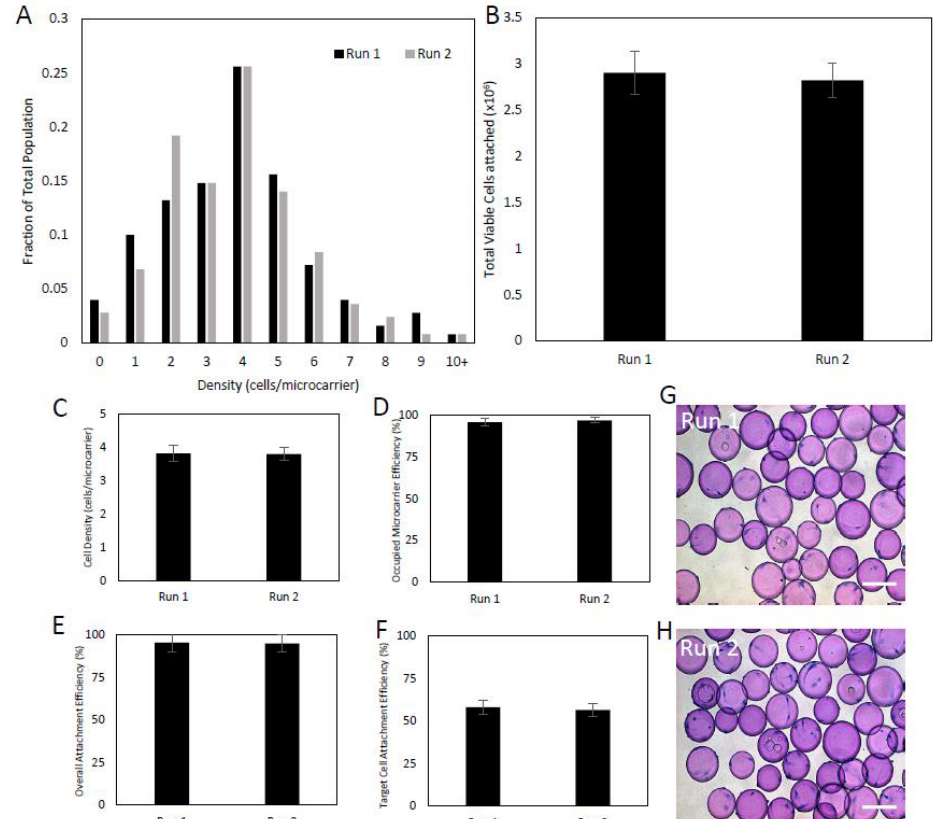
Figure 2. Attachment and distribution of Sk-SCs on Cytodex 3 microcarriers. Two independently isolated and cryopreserved Sk-SC samples were thawed into 500 mL DASGIP bioreactors running with intermittent agitation for the first 24 h (four 5-min agitation periods/hour at 40 rpm for 24 h). After 24 h, samples were taken to obtain the distribution ( A ), total viable attached cells ( B ), cell density ( C ), number of microcarriers with at least 1 cell ( D ), the overall attachment efficiency ( E ), and number of microcarriers achieving the target loading ( F ). ( G , H ) Photomicrographs of microcarriers 24 h after inoculation for runs 1 and 2, respectively. Scale bars represent 200 μm. Error bars represent one standard deviation of the mean.